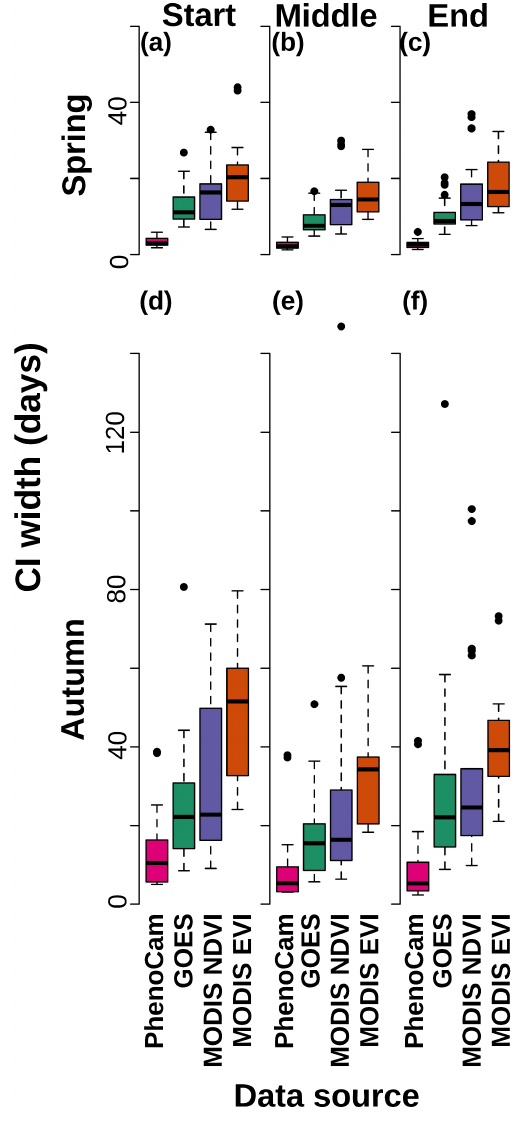
Figure 4. The 95% credible interval (CI) widths for the different data sources for spring start (a) , middle (b) , and end (c) and autumn start (d) , middle (e) , and end (f) . Colors denote the different data sources, which are labeled on the x axis. PhenoCam had the most certain transition date estimates, and GOES was always more cer- tain than MODIS EVI but only more certain than MODIS NDVI for the middle and end of